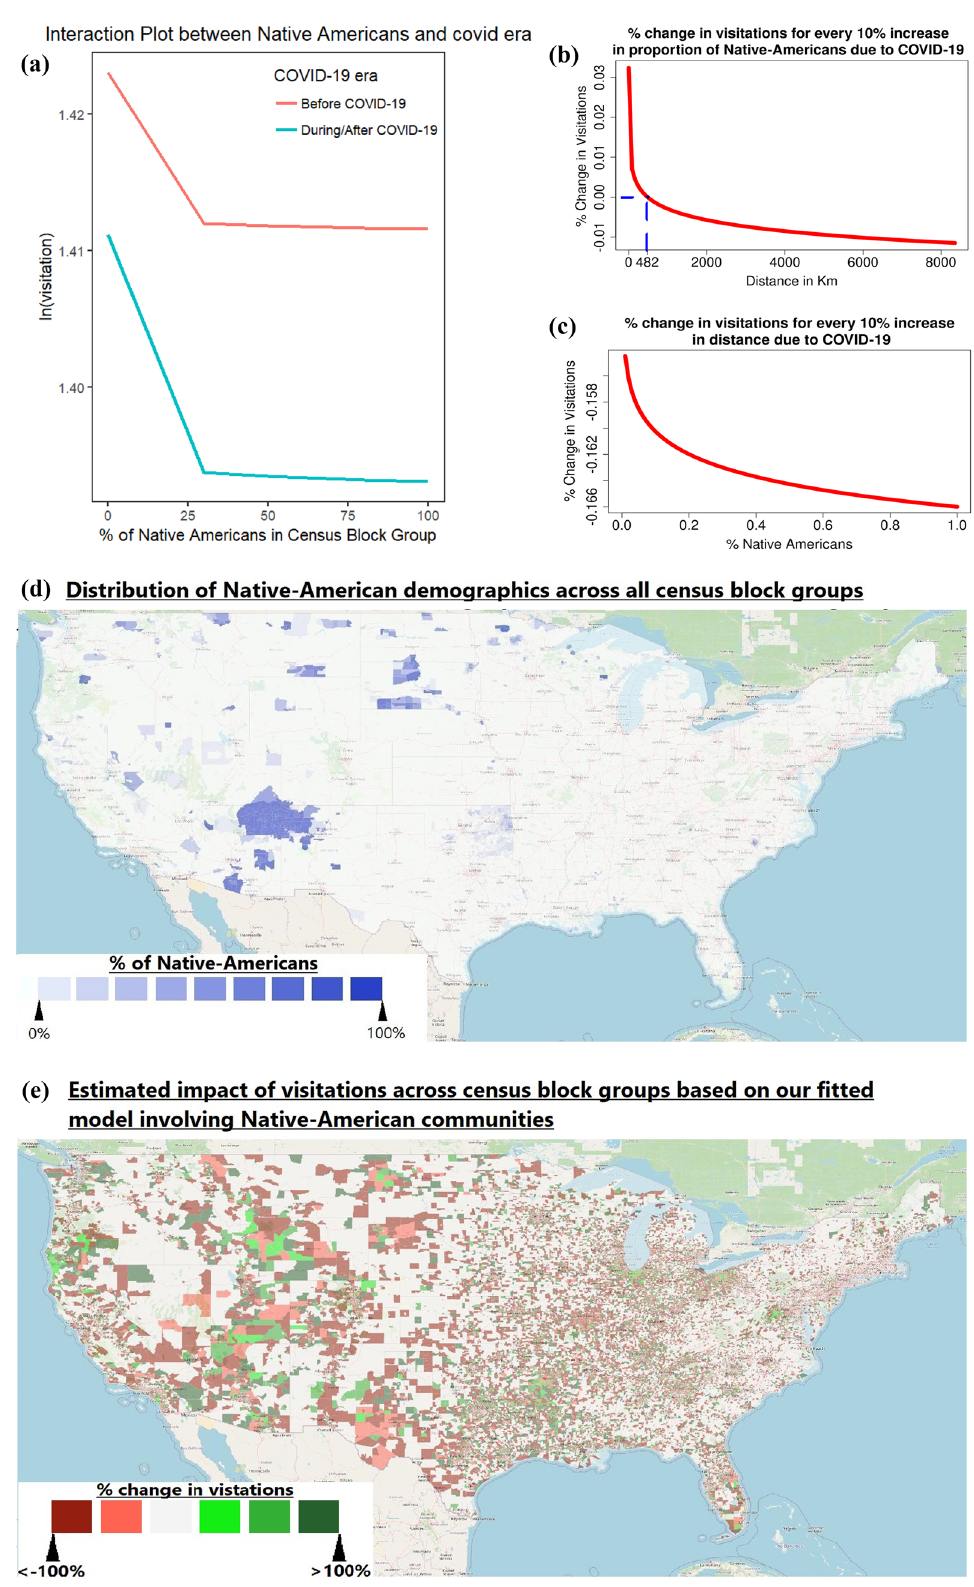
Figure 7. Illustration of the of impact of COVID-19 towards visitations to national parks from Native American communities. ( a ) On the left reflects the interaction plot of percent of Native Americans in a census block group and its impact on park visitations to national parks due to COVID-19. ( b , c ) On the right reflects changes of visitation to each national park due to COVID-19 for every 10% increase of the proportion of Native Americans and distance travelled respectively. ( d , e ) Allow us to compare the demographics of Native-Americans across census block groups and our estimated impact on their overall visitation figures to national parks due to COVID-19, respectively. The maps were generated using QGIS 25 , with the map layers being facilitated by OpenStreetMaps 26